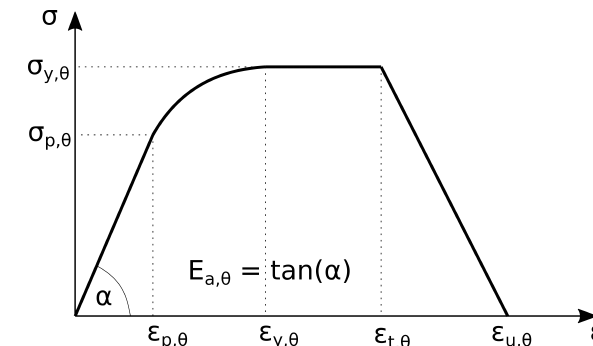
Figure 15. Considered strain-stress diagram of steel, given by